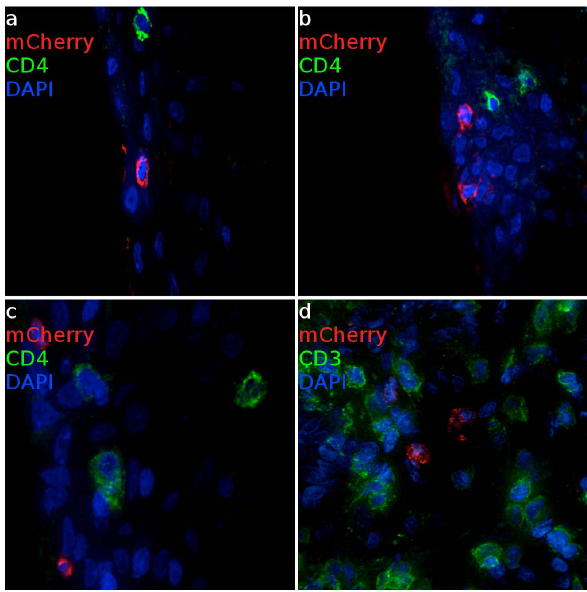
Figure 3. Infected cells from ectocervical and vaginal tissue of VSV-G enveloped reporter inoculated Rhesus Macaques. (a, b) Virus primarily infects epithelial cells within the ectocervix. CD4 expressing cells cluster proximal to mCherry expressing cells but are not infected. (Animal code: FM27) (c) Epithelial and (d) sub-epithelial cells in the vagina are also susceptible to infection. Where infection is found, there are abundant numbers of T cells are present. (Animal code: FM28) mCherry signal is shown in red. CD3 or CD4 is shown in green. Nuclei (DAPI) are shown in blue. Scale bars, 30 m m.